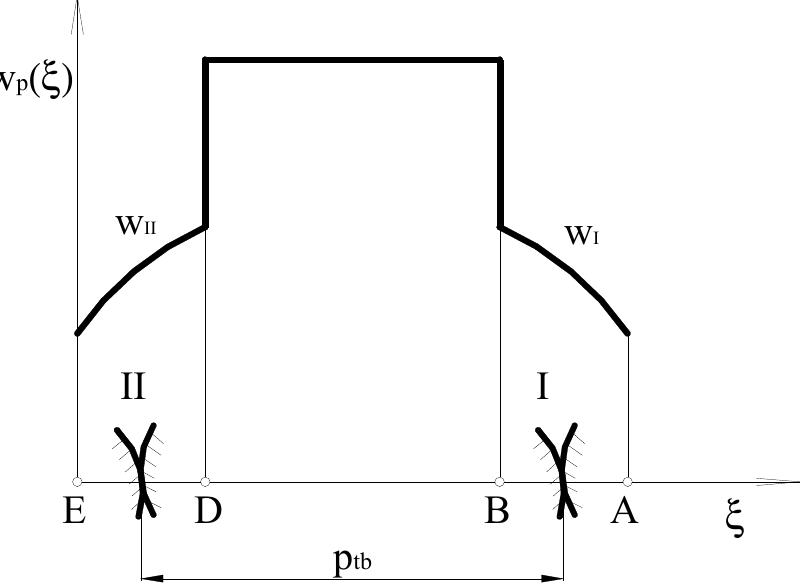
Figure 3. Load of individual pairs of teeth of precise straight spur gearing (sections AB and DE are two engaging gear pairs of teeth; section BD is one engaging gear pair of